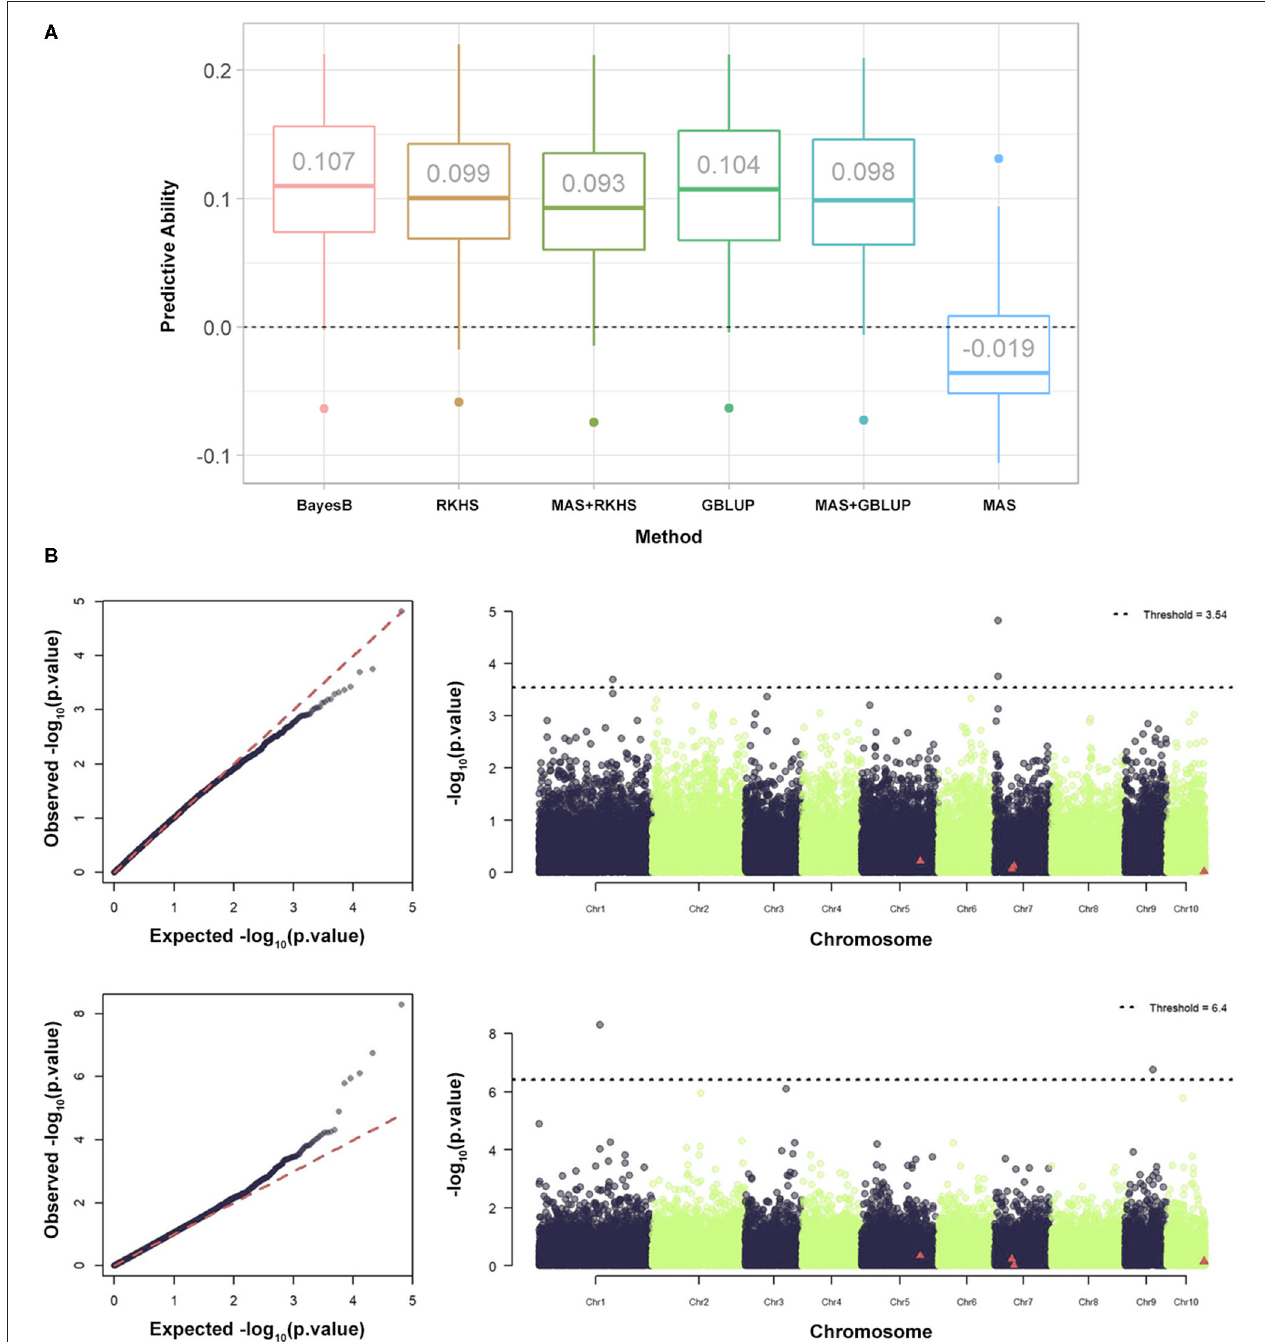
FIGURE 4 | Performance of different statistical models and GWAS-based strategies for genomic prediction of maize hybrids. (A) Summary of the predictive capabilities of the Low Nitrogen Tolerance Index (LNTI) in maize hybrids using BayesB, RKHS, MAS + RKHS, GBLUP, MAS + GBLUP, and MAS additive. (B) Summary of GWAS, QQ, and Manhattan graphs for LNTI. The graphs represent additive GWAS (upper) and dominance (lower). The MAS was based on statistically significant associations identified for LNTI by Morosini et al. (2017).